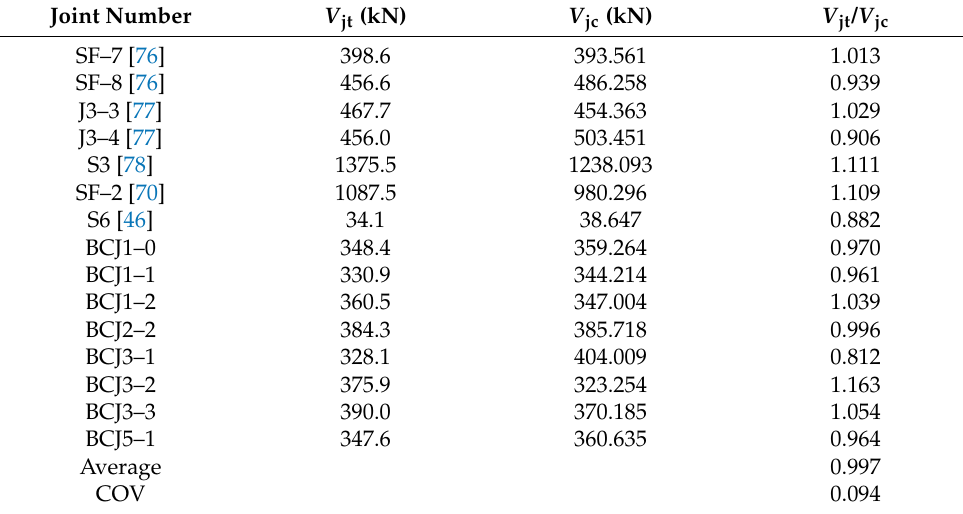
Table 5. Comparison between calculated results and experimental results of ultimate shear capacity of